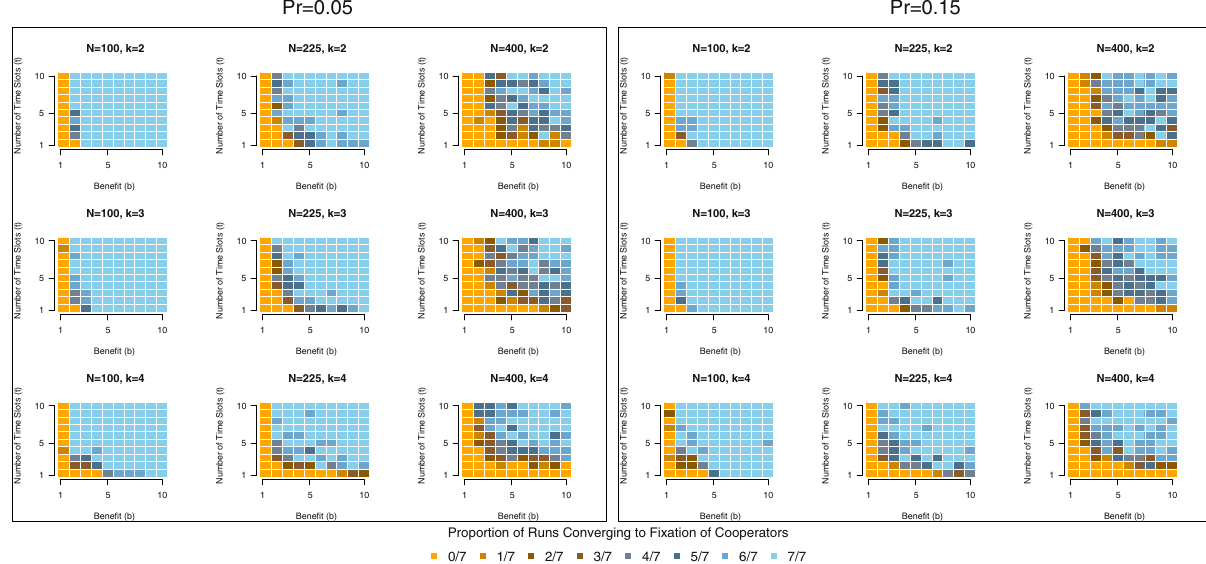
Fig. 4 Cooperator fi xation becomes more frequent across runs as bene fi t ( b ) and the number of time slots ( t ) increase in the small-world network model. The panels display the frequency of cooperator fi xation in simulation runs in which agents reside in a small-world network. Regardless of rewiring probability, Pr , we observe cooperator fi xation more frequently as b and t take higher t = 5, and peaks at 83.9% when t = 10. Likewise, as the value of b increases, the frequency of runs in which cooperators reach fi xation increases; simulation runs ending with a population replete with cooperators occur extremely rarely when b = 1, but 45.5% of runs end with cooperator fi xation when b = 2 and 91.2% of runs do when b = 10. As evident in Fig. 4, we again see that the population converges more slowly with larger values of N . in fl uence the simulation ’ s results — as a comparison of the left- and right-half of Fig. 4 indicates. When Pr. = 0.05, 71.7%% of all runs result in the fi xation of cooperators; a comparable 72.6% of all runs result in the fi xation of cooperators when Pr = 0.15.